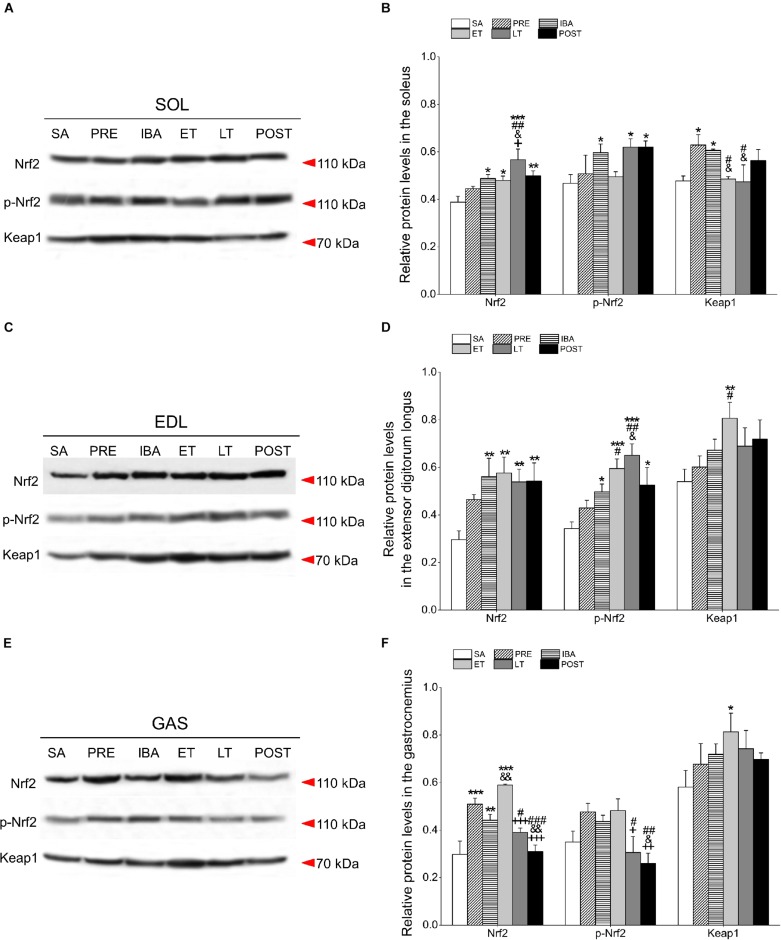
Changes in Nrf2, p-Nrf2, and Keap1 protein levels in different skeletal muscles of Daurian ground squirrels over the torpor-arousal cycle. (A) Representative immunoblots of Nrf2, p-Nrf2, and Keap1 in SOL during six hibernation periods. (B) Relative Nrf2, p-Nrf2, and Keap1 protein expression in SOL. (C) Representative immunoblots of Nrf2, p-Nrf2, and Keap1 in EDL during six hibernation periods. (D) Relative Nrf2, p-Nrf2, and Keap1 protein expression in EDL. (E) Representative immunoblots of Nrf2, p-Nrf2, and Keap1 in GAS during six hibernation periods. (F) Relative Nrf2, p-Nrf2, and Keap1 protein expression in GAS. SA, summer active; PRE, pre-hibernation; IBA, interbout arousal; ET, early torpor; LT, late torpor; POST, post-hibernation. Values are means ± SEM, n = 8. ∗P < 0.05, Compared with SA; ∗∗P < 0.01, compared with SA; ∗∗∗P < 0.01, compared with SA; #P < 0.05, compared with PRE; ##P < 0.01, compared with PRE; ###P < 0.01, compared with PRE; &P < 0.05, compared with IBA; &⁣&P < 0.01, compared with IBA; +P < 0.05, compared with ET; ++P < 0.01, compared with ET; +⁣++P < 0.001, compared with ET.